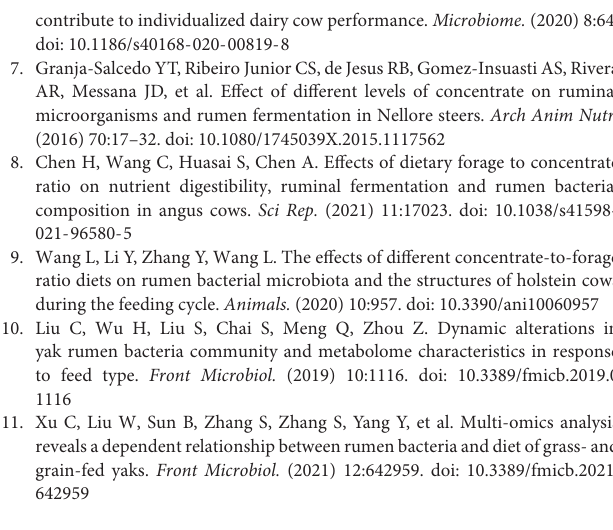
Supplementary Figure 1 | Rarefaction curves for each sample in three groups. Supplementary Figure 2 | Venn diagram of Operational Taxonomic Units (OTUs) in three groups. Supplementary Figure 3 | Principal component analysis (PCA) score plots of metabolite profile. Supplementary Table 1 | Composition and nutrient levels of experimental diets. Supplementary Table 2 | List of identified